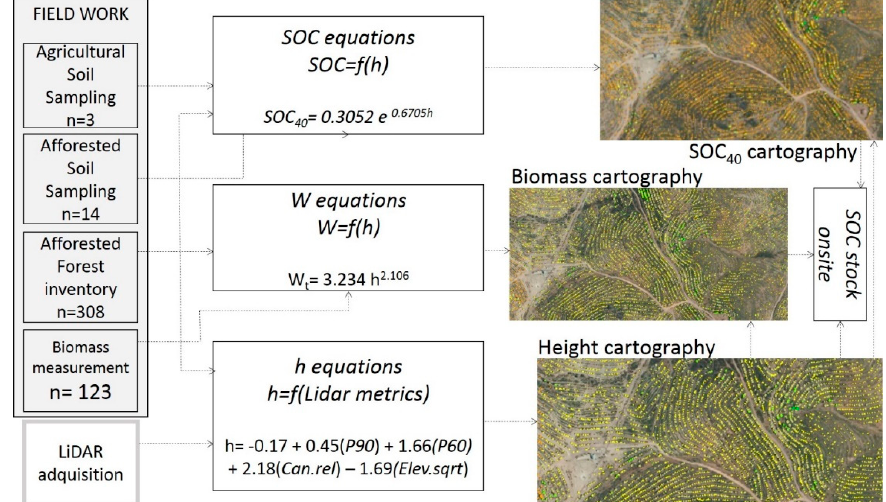
Figure 1. Flowchart describing the methodological steps of C stock estimation in a Quercus ilex-Q. suber plantation in Southeastern Andalusia using field and aerial laser scanning (ALS) data .